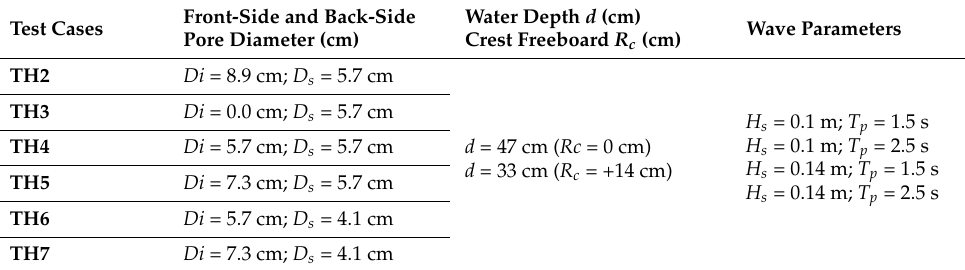
Table 5. Scenarios for finding the optimal pore diameter.